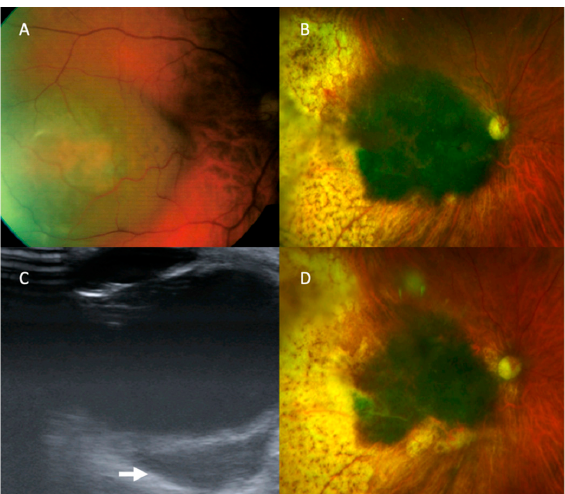
Figure 2. Tumour recurrence in the one patient with clear media whose recurrence could not be diagnosed on colour photography. ( A ) The tumour at presentation. ( B ) The tumour following initial treatment with plaque brachytherapy and salvage therapy with proton beam radiotherapy. ( C ) B-scan ultrasound demonstrating extrascleral extension (arrow points to area of extrascleral extension). ( D ) Colour photograph of the tumour at the time extrascleral extension was diagnosed.